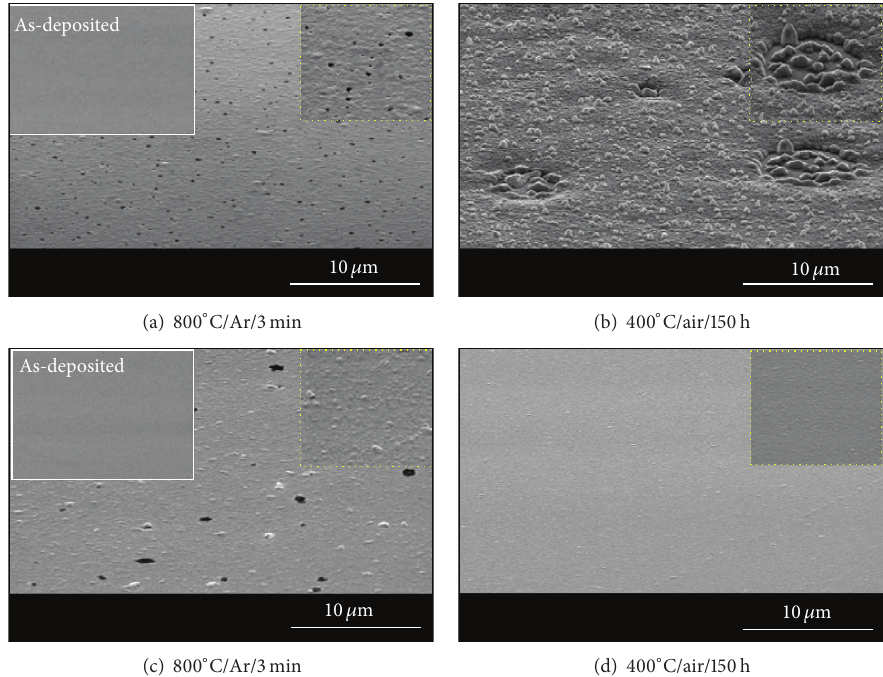
Figure 18: SEM micrographs of the Au/Ni 2 Si/ n -SiC (a and b) and Au/Ta 35 Si 15 N 50 /Ni 2 Si/ n -SiC (c and d) ohmic contacts: (a, c) as-deposited and after annealing in Ar at 800 ∘ C (3 min); (b, d) after aging in air at 400 ∘ C (150h) [85–88]. The yellow squares show the SEM micrographs with higher resolution for the contacts after heat